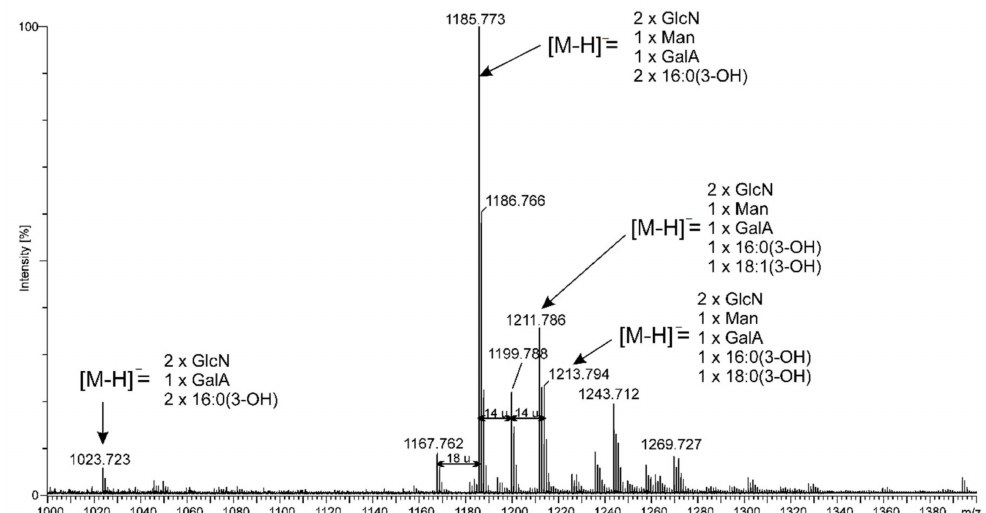
Figure 2. ESI-MS mass spectrum in the negative ion mode of O -de-acylated Rv lipid A.